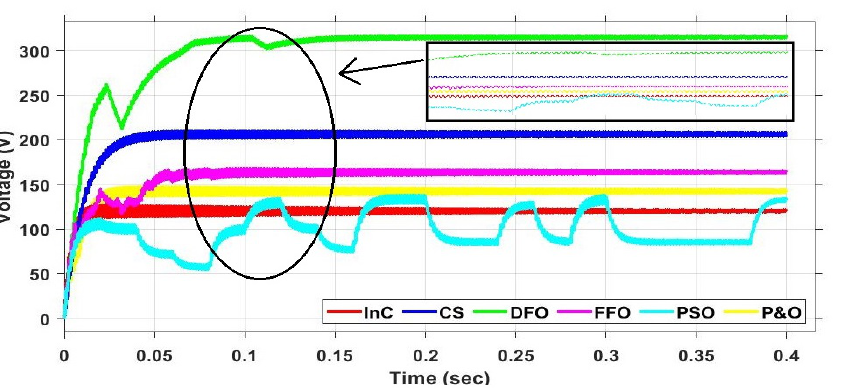
Figure 18. PS2 voltage comparison between all algorithms for centralized PV system.